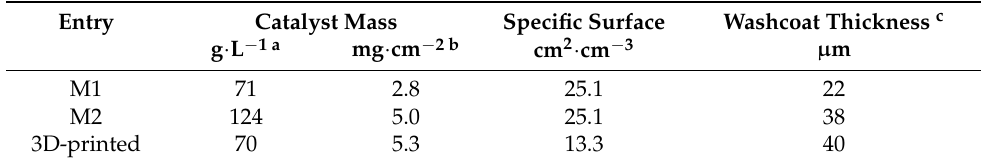
Table 1. Characteristics of the three monolith cores studied for NH 3